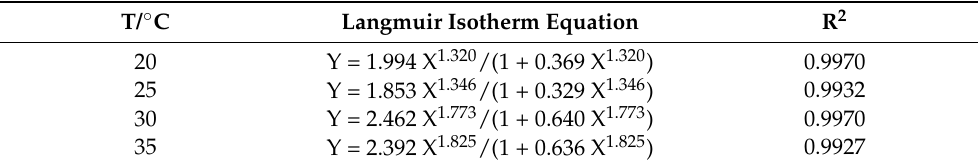
Table 3. Adsorption isotherm